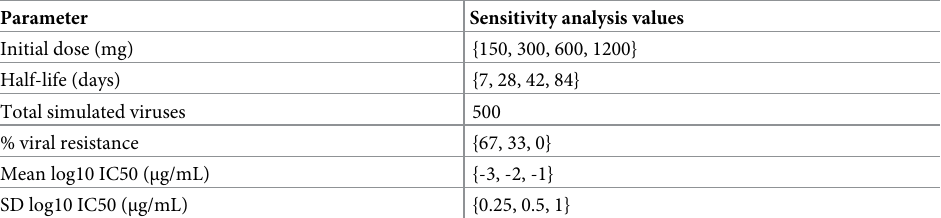
Table 2. Parameter settings for global sensitivity analysis combining two